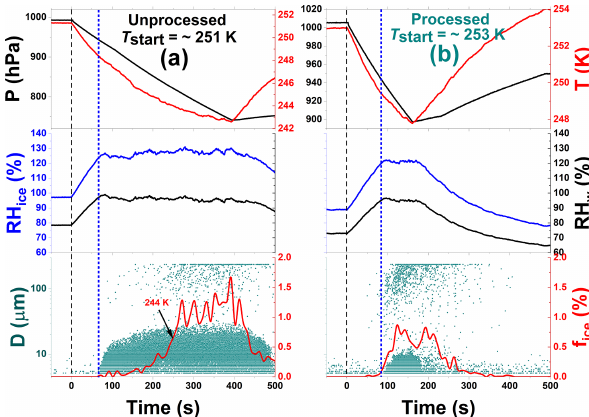
Figure 5. Summary of the maximum ice-activated fraction (%) of unprocessed and processed CFA_UK particles as a function of tem- perature. The temperatures referenced on the x axis are the tem- perature at which the maximum ice-activated fraction was reached during each experiment. The grey/black columns on the right-hand side of the plot indicate experiments before the TCF procedure and the cyan/dark cyan columns on the left-hand side show experiments after the TCF process.